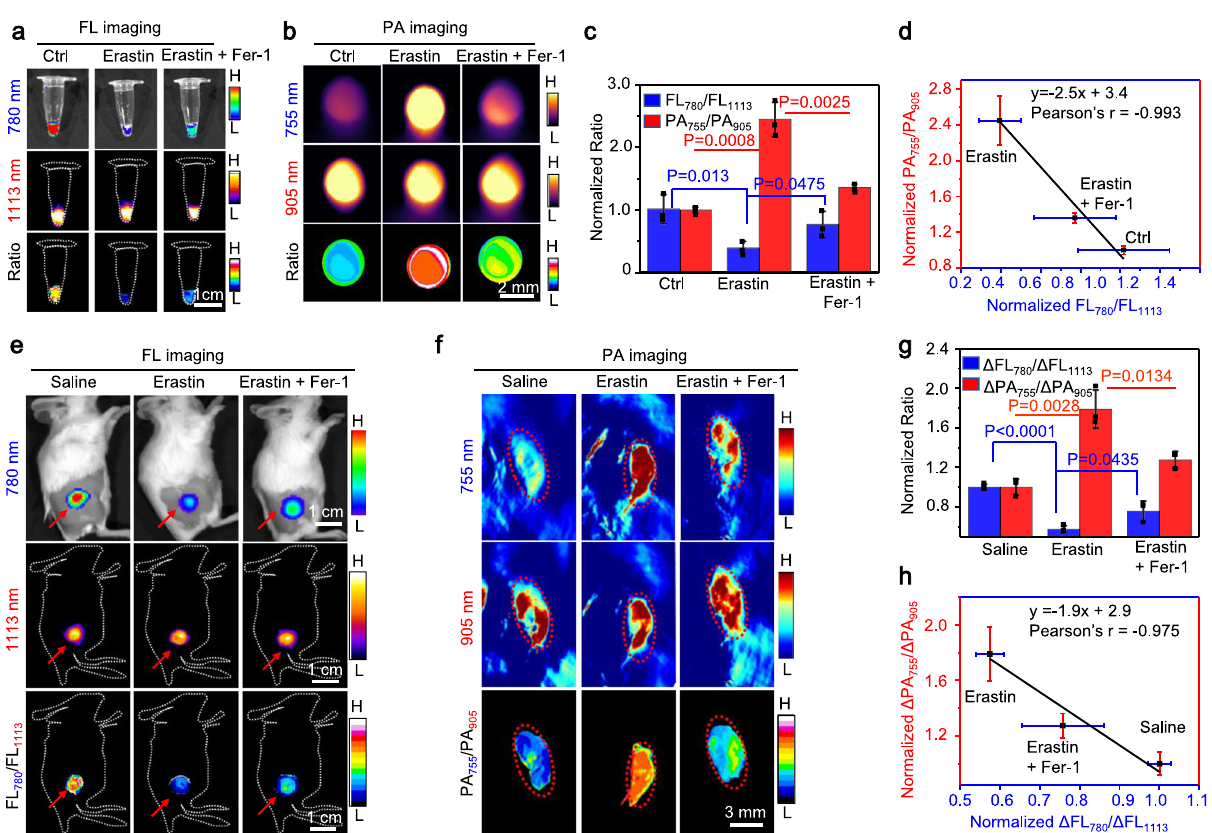
Fig. 5 Ratiometric bimodal imaging of (cid:129) OH in 4T1 tumors undergoing ferroptosis. a Fluorescence (FL) (780 and 1113 nm) and ratiometric FL 780 /FL 1113 images, and b Photoacoustic (PA) images (755 and 905 nm) and ratiometric PA 755 /PA 905 images of 4T1 cells upon incubation with 1-NP-FA (Ctrl), 1-NP- FA + erastin or 1-NP-FA + erastin + Fer-1. Cells were untreated (Ctrl), or pretreated with 10 μ M erastin to induce ferroptosis, or 10 μ M erastin plus 10 μ M Fer-1 for 6 h, and then incubated with 1-NP-FA (56/1.65/20 μ M 1-Br-Et/NIR775/IR1048) for another 2 h. c Normalized FL 780 /FL 1113 and PA 755 /PA 905 ratios of 4T1 cells treated with indicated conditions in a and b . d Plot of the FL 780 /FL 1113 ratios versus PA 755 /PA 905 ratios shows a strong correlation ( r = − 0.993) between them in 4T1 cells after indicated treatment. e FL and ratiometric FL 780 /FL 1113 images, and f PA images and ratiometric PA 755 /PA 905 images of s.c. 4T1 tumors upon treatment with saline, erastin or erastin plus Fer-1, followed by intravenous (i.v.) injection of 1-NP-FA. Mice with subcutaneous (s.c.) 4T1 tumors were intraperitoneal (i.p.) injected with saline, erastin (20 mg kg − 1 ) or erastin (20 mg kg − 1 ) plus Fer-1 (20 mg kg − 1 ), and 12 h later, 1-NP-FA (1.68/ 0.05/0.6mM 1-Br-Et/NIR775/IR1048, 200 μ L) were i.v. injected into mice. After 24 h, the FL and PA images were acquired. Red arrows in ( e ) and red circles in ( f ) indicate the tumor locations. g Normalized Δ FL 780 / Δ FL 1113 and Δ PA 755 / Δ PA 905 ratios in 4T1 tumors following indicated treatment. h Plot of the Δ FL 780 / Δ FL 1113 ratios versus Δ PA 755 / Δ PA 905 ratios show a strong correlation ( r = − 0.975) between them in 4T1 tumors following indicated treatment. Data are presented as mean ± s.d. ( n = 3 independent cell pellets or mice). Statistical differences were analyzed by Student ’ s two-sided t -test. Source data are provided as a Source Data fi